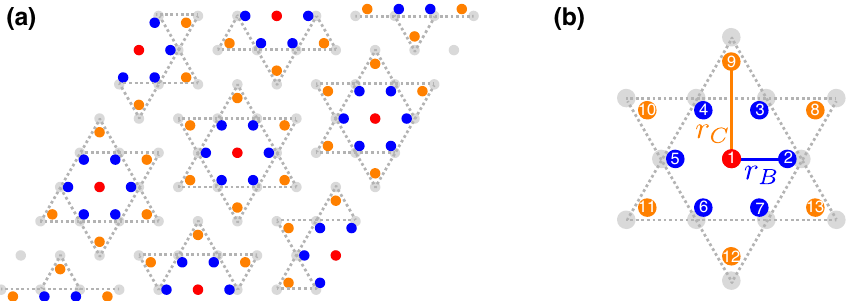
Figure 1. ( a ) PLD in hexagram configuration in real space (exaggerated). The red, blue, and orange dots show “A”, “B”, and “C” Ta atoms, respectively. For reference, Ta atoms without PLD are shown by the gray dots; ( b ) parameters r B and r c characterizing distorted hexagram configuration. The configuration is assumed to be symmetric under the π /3 rotation and the mirror transformation about the x -axis. The site indices will be used in Section